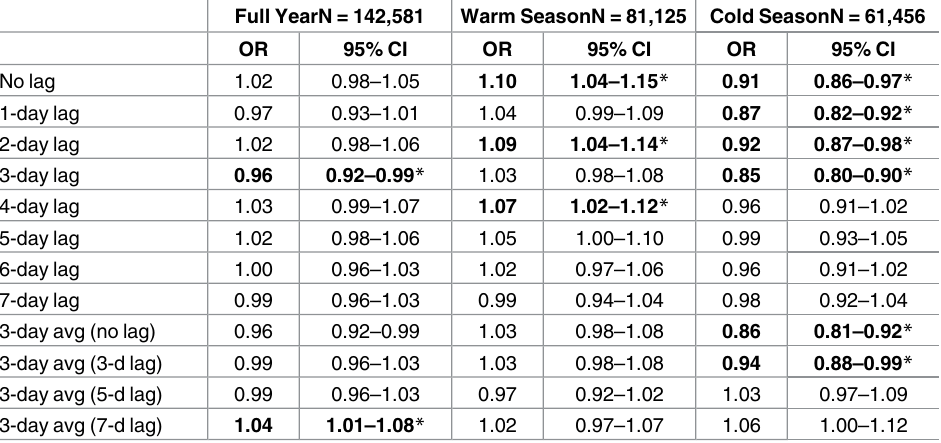
Table 2. Adjusted odds ratios (OR) and 95% confidence intervals (CI) of association with 90 th percen- tile precipitation and hospitalizations for gastrointestinal illness by